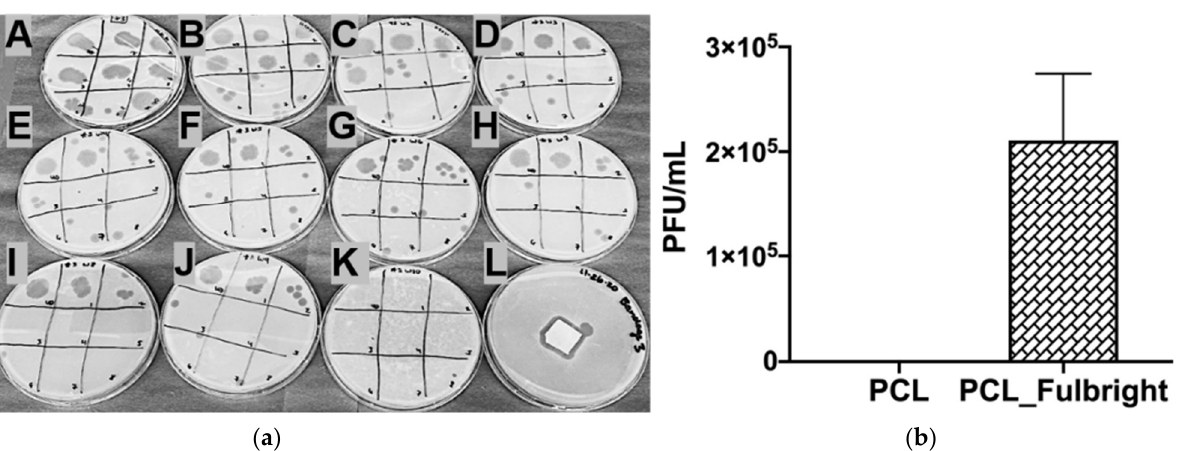
Figure 5. ( a ) In vitro phage release and ( b ) phage viability assay. ( a ) Each ( A – K ) represents the spot test of phage buffer after each wash. The spots on each plate represent the 10-fold dilutions of the phage buffer. ( A – J ) indicate the release of phage Fulbright from the nanofiber into the phage buffer. ( K ) indicates no residual phages in the phage buffer. ( L ) shows a clear zone around the washed nanofiber incubated on a lawn of host cells. ( b ) The graph panel represents the number of viable phage particles in the viability assay.